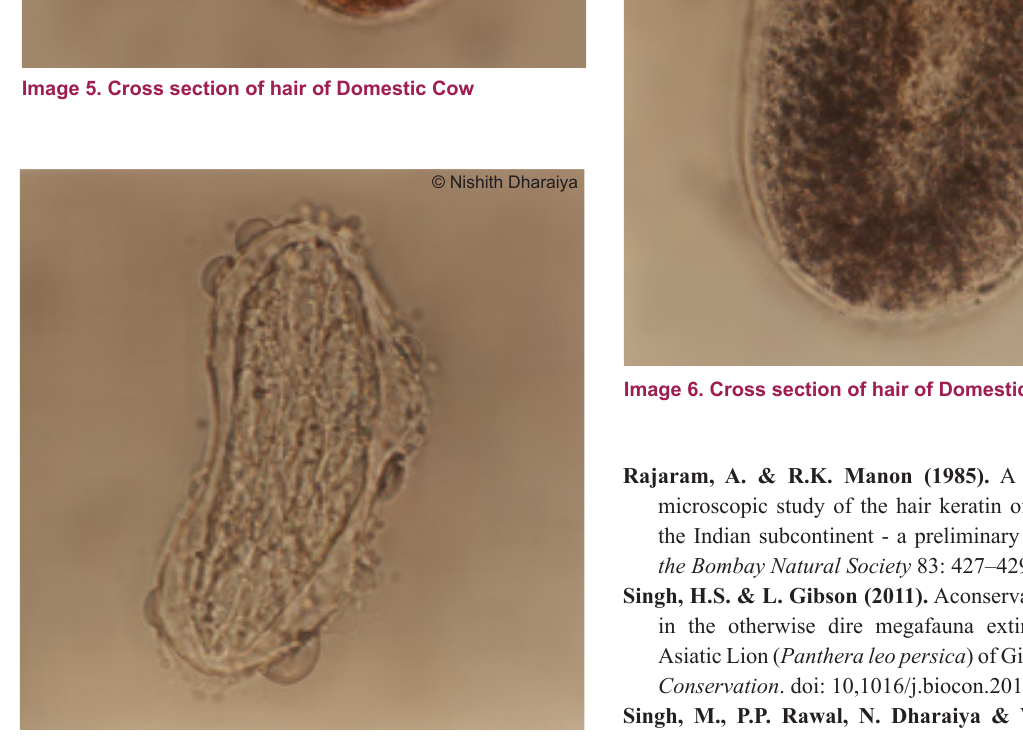
Image 7. Cross section of hair of Domestic